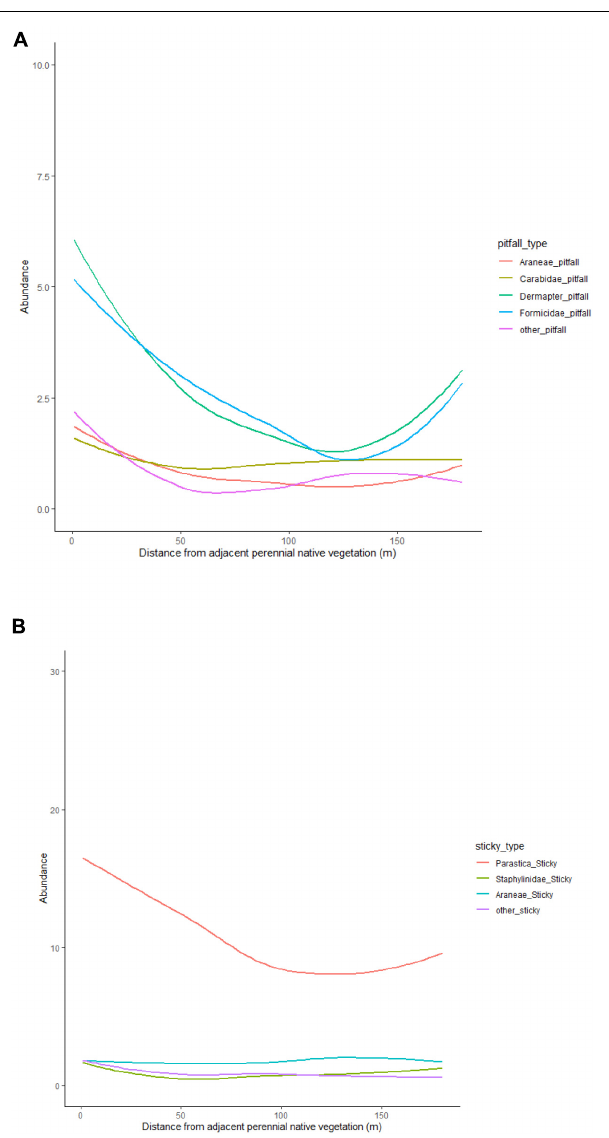
FIGURE 5 | Effect on natural enemy groups of perennial woody vegetation adjacent to one margin of a brassica vegetable field with a pesticide regime calculated to have low toxicity. (A) Ground active predators (pitfall trap catches) and (B) aerial groups, including ballooning spiders (sticky trap